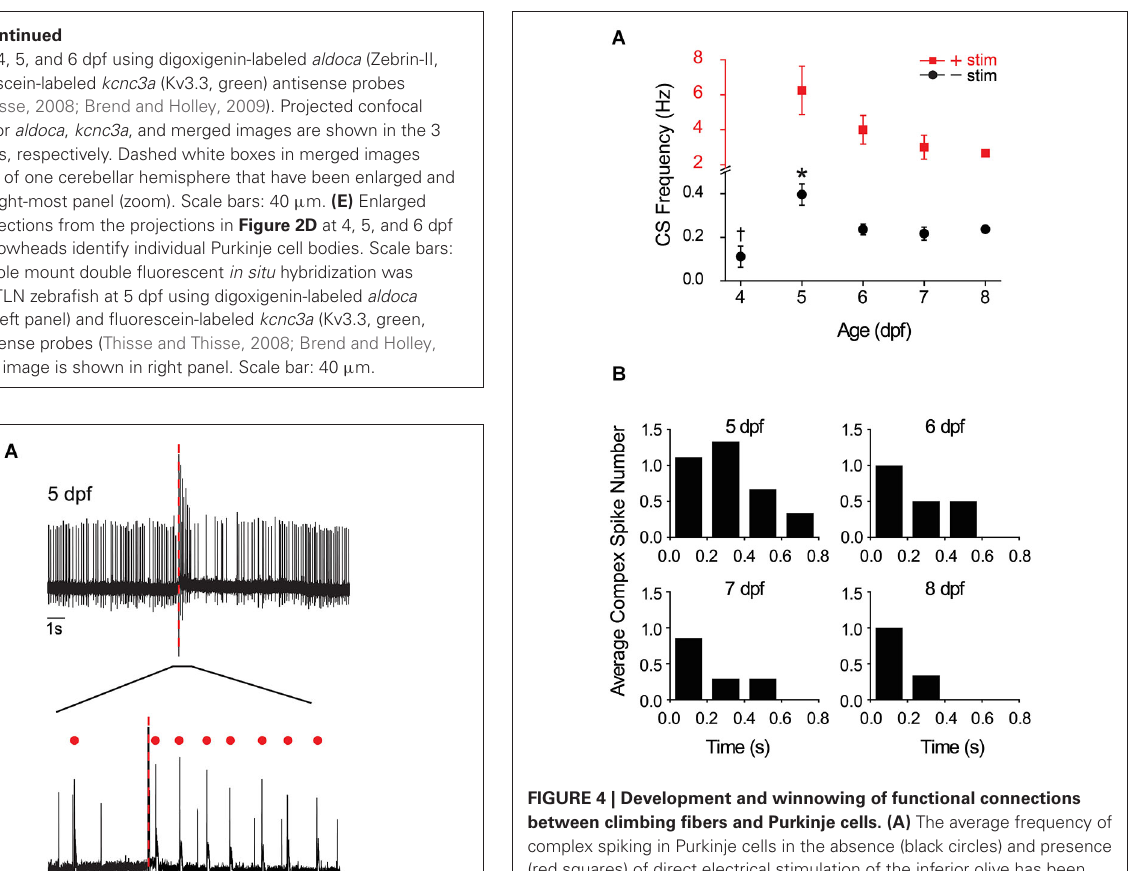
innervated by multiple climbing fibers. Over the next 2 weeks, these inputs are winnowed by activity-dependent competition until each Purkinje cell is innervated by a single “winner”